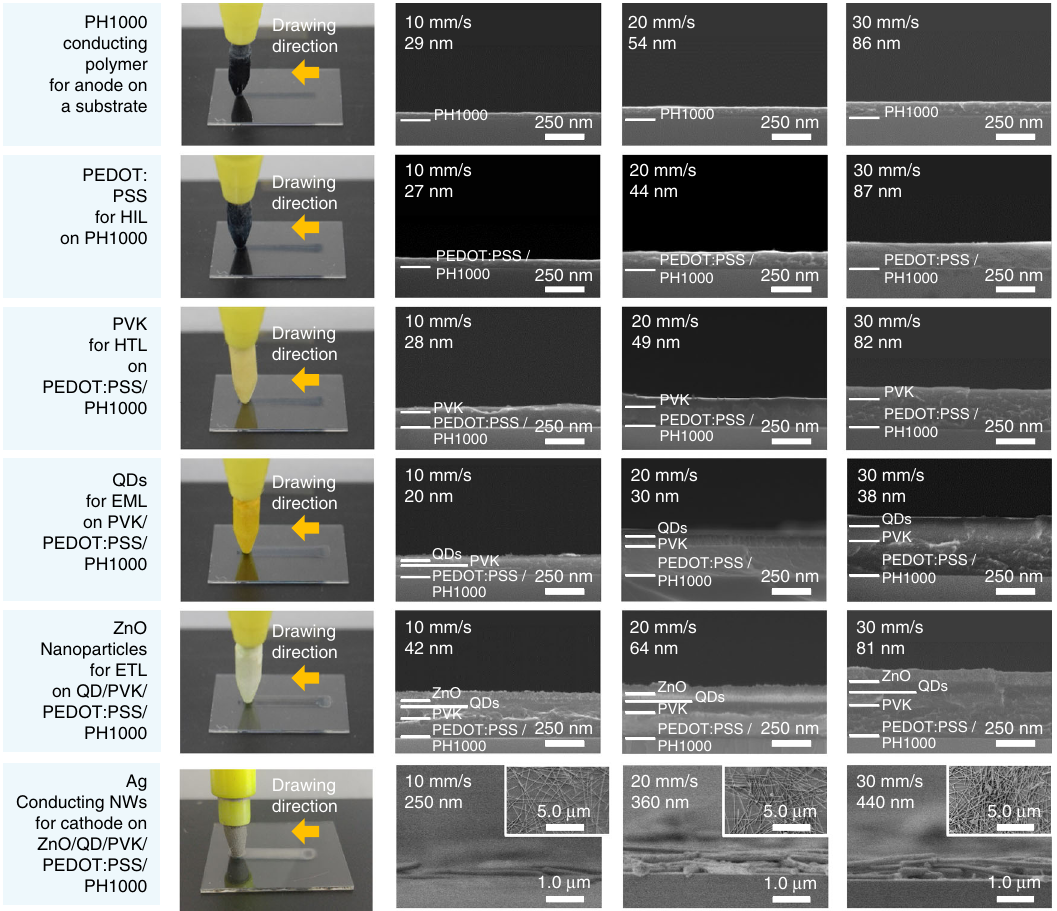
Fig. 2 Gallery of pen-drawing images. PH1000, PEDOT:PSS, poly( N -vinylcarbazole) (PVK), QDs, ZnO NPs, and Ag NWs were deposited in order, and the thickness of each layer was observed using FE-SEM. The nanometer-scale thickness could be controlled by manipulating the drawing speed while the number of drawing cycles (1 half-cycle) and substrate temperature (20 °C) were fi